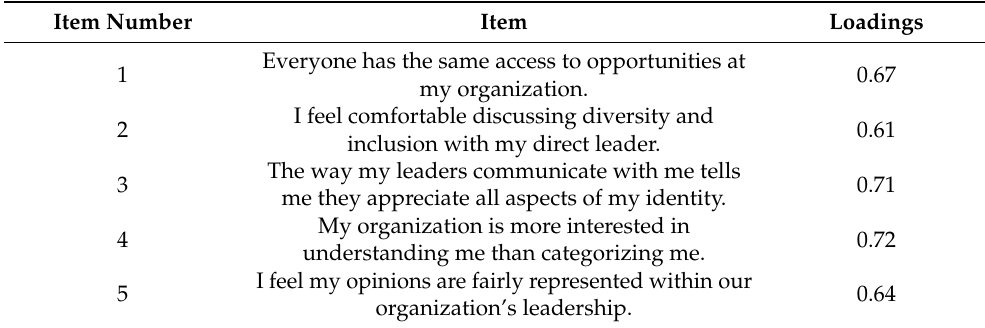
Table 1. Inclusion Sentiment Scale Items and Factor